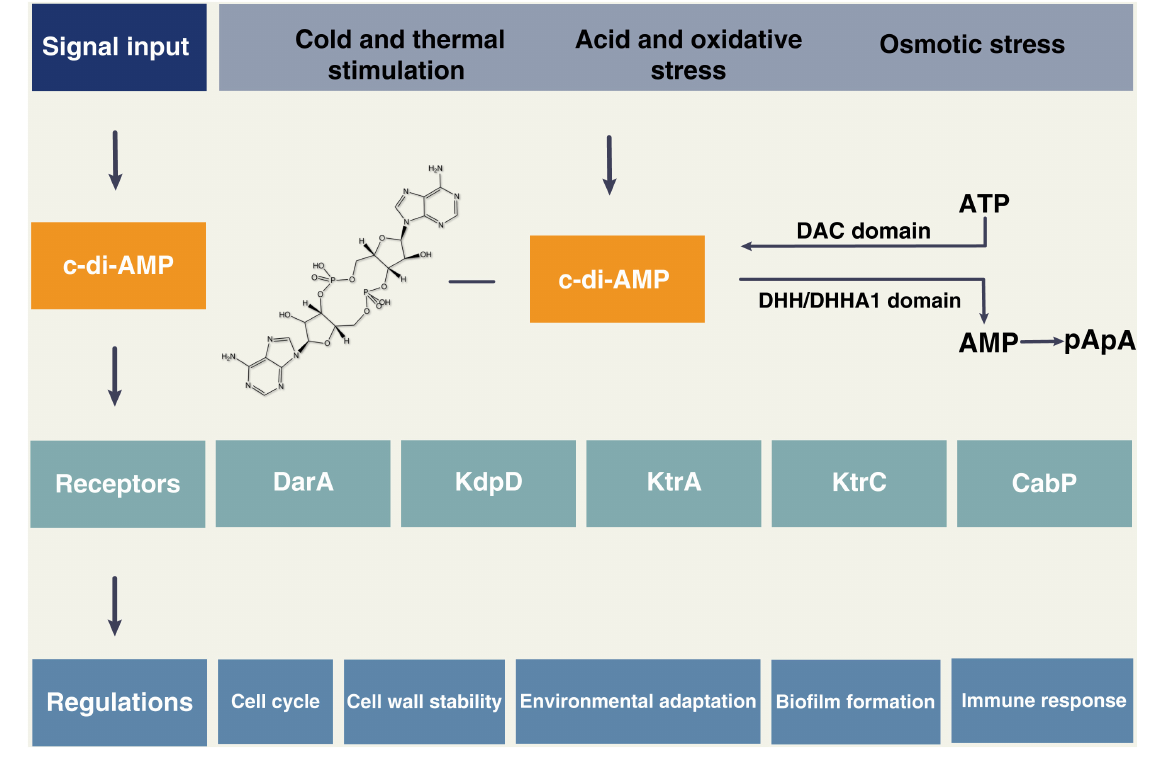
FIGURE1 The cyclic di-adenosine monophosphate (c-di-AMP) signal system. c-di-AMP can be synthesized from ATP via proteins containing the DAC domain, and proteins containing DHH/DHHA1 domain can degrade c-di-AMP into AMP or pApA. The external stimuli can induce the production of c-di-AMP, which then binds to the receptors such as DarA, KdpD, KtrA, KtrC, and CabP. The c-di-AMP signaling pathway is involved in many bacterial physiological activities, such as the cell cycle, cell wall stability, environmental stress response, biofilm formation, and host immune